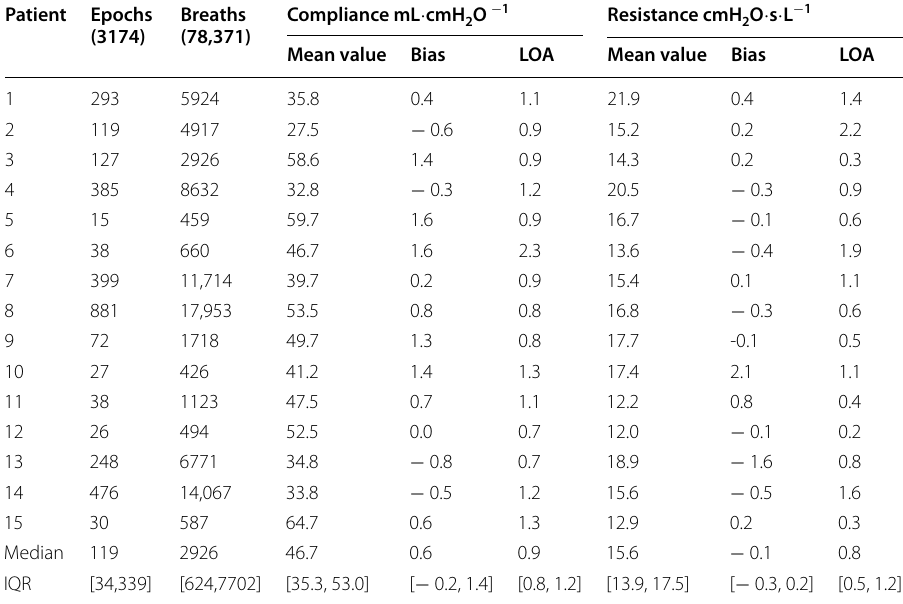
Table 2 Bland–Altman analysis of respiratory system’s static compliance and resistance values calculated by the static and dynamic methods for individual